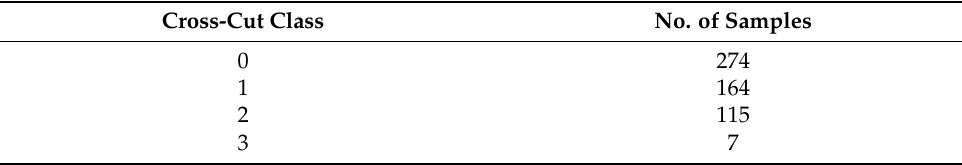
Table 2. Distribution of the obtained cross-cut classes. Table 1. Distribution of the obtained cross-cut